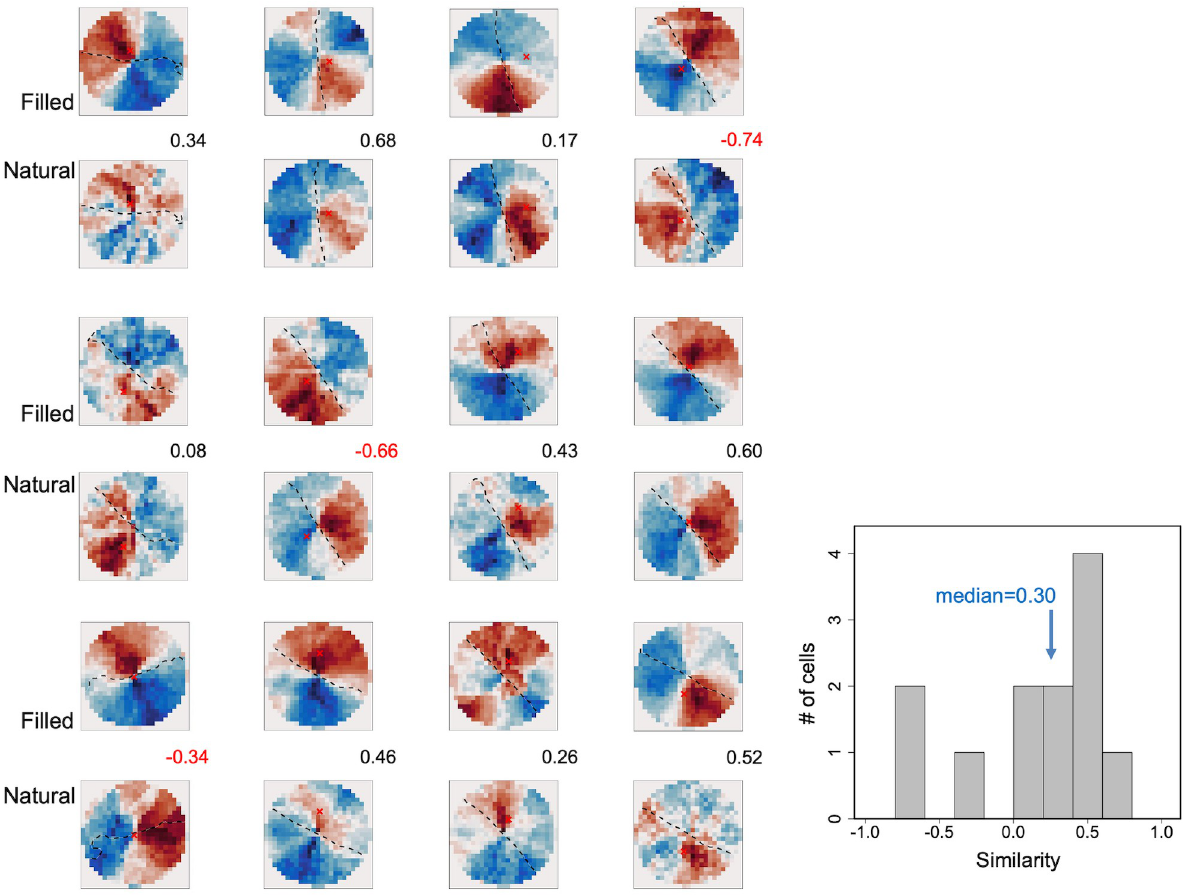
Fig 5. Similarity between RF-FGs estimated from filled and natural stimuli. The estimated RF-FG STA s of twelve neurons that responded to both natural and filled stimuli (in odd and even numbered rows, respectively). The same conventions were used as Fig 2. The values between the panels indicate the cosine similarity between the RF-FG STA s estimated from filled and natural stimuli. The magnitudes were normalized for each neuron. The reddish and blueish colors indicate figure- and ground-subregions, respectively, with the deeper colors representing the greater magnitudes. The right panel shows the distribution of the